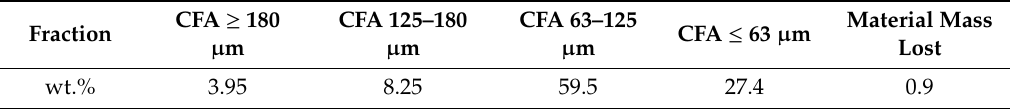
Table 1. Weight percent of each fraction referring to the total mass of CFA.